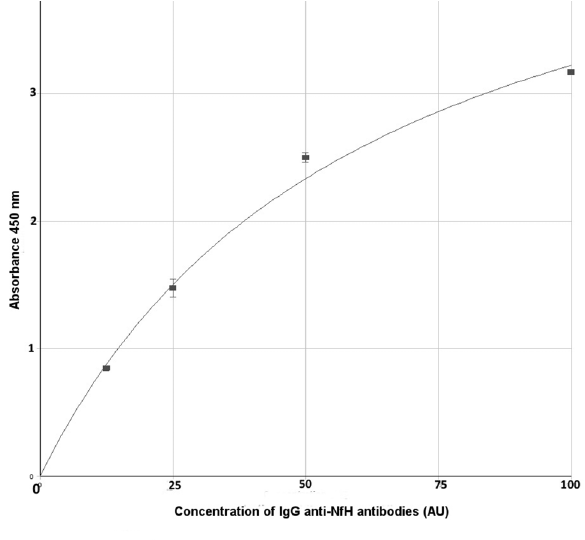
Fig. 1. Example of the calibration curve for the expression of anti-NfH IgG antibody concentration in arbitrary